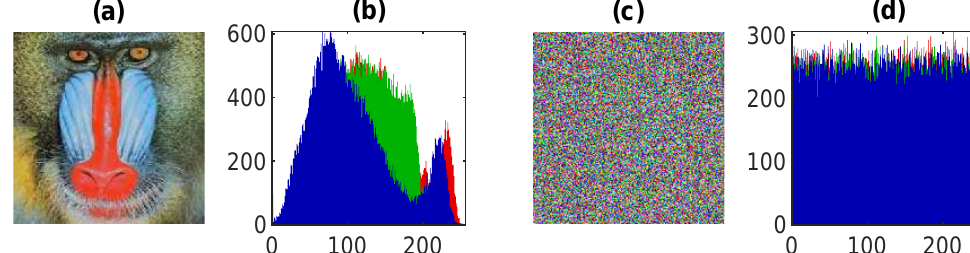
Figure 10. Histogram analysis of the image in Figure 2d: ( a ) the original image, ( b ) histogram of the original image, ( c ) encrypted image, ( d ) histogram of the encrypted image.